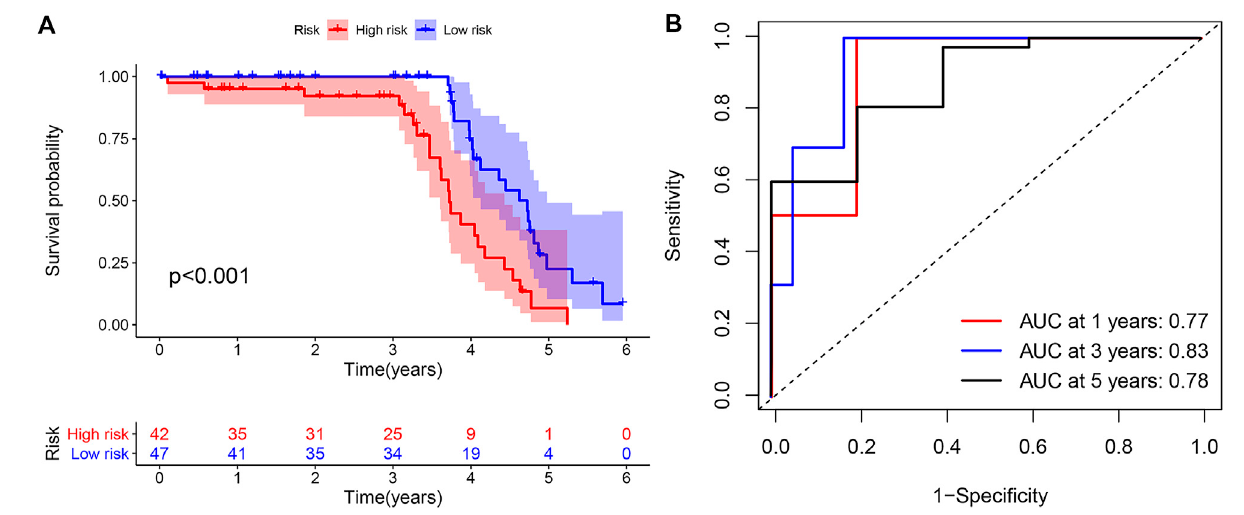
FIGURE5|(A) Kaplan – Meiercurveofoverallsurvivalinexternalvalidationgroup. (B) TimeROCcurvesfor1,3,5 yearsinexternalvalidationgroup.TimeROC:time- dependent ROC.